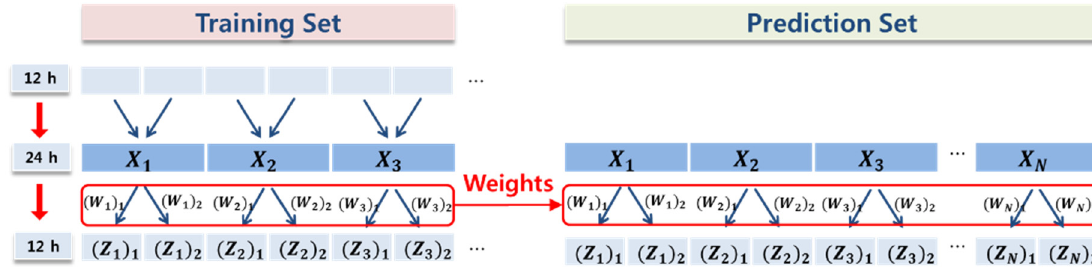
Figure 3. The concept of weighting in chaotic disaggregation.